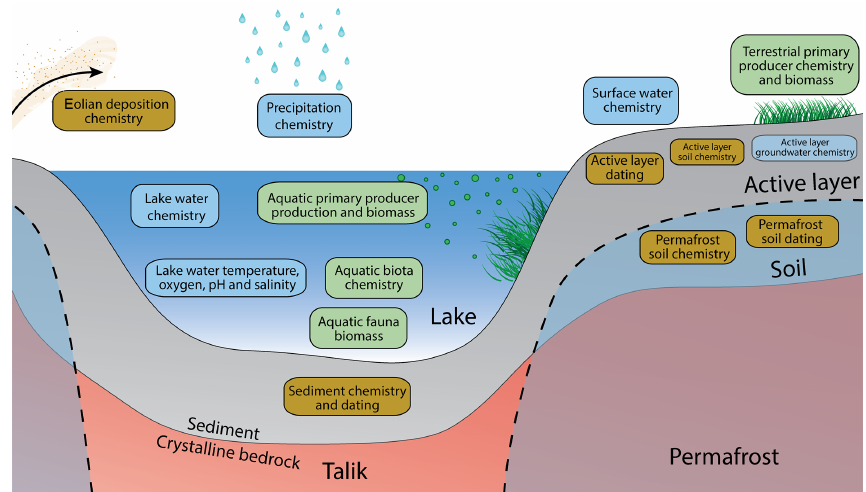
Figure 3. Conceptual model of the TBL catchment describing major ecosystem entities (boxes) in the landscape. Boxes are divided into water (blue), biotic (green) and solid matter